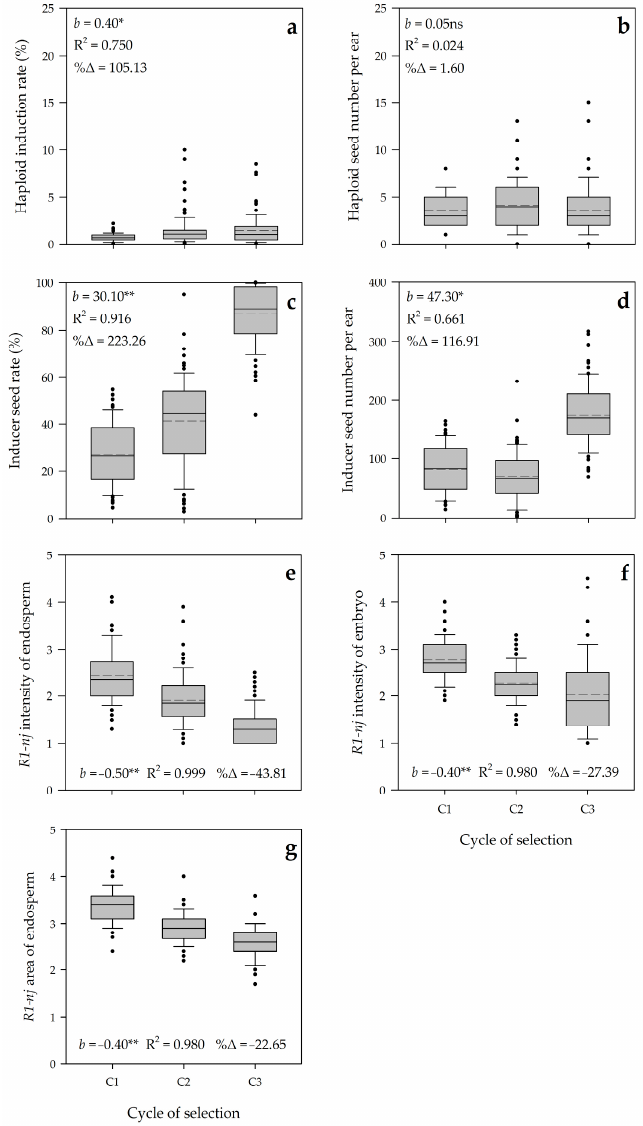
Figure 5. Parallel boxplots of 78 families of putative tropical haploid inducer in three cycles of selection for haploid induction ability. ( a ) Haploid induction rate (%); ( b ) Haploid seed number per ear; ( c ) Inducer seed rate (%); ( d ) Inducer seed number per ear ( e ) R1-nj intensity of endosperm; ( f ) R1-nj intensity of embryo; and ( g ) R1-nj area of endosperm. b realized genetic gain per cycle. R 2 coefficient of determination. % ∆ is percentage increase due to selection. *, ** b values are significantly different from zero at ≥ 2SE and ≥ SE, respectively. ns b value is not significantly different from zero at ≥